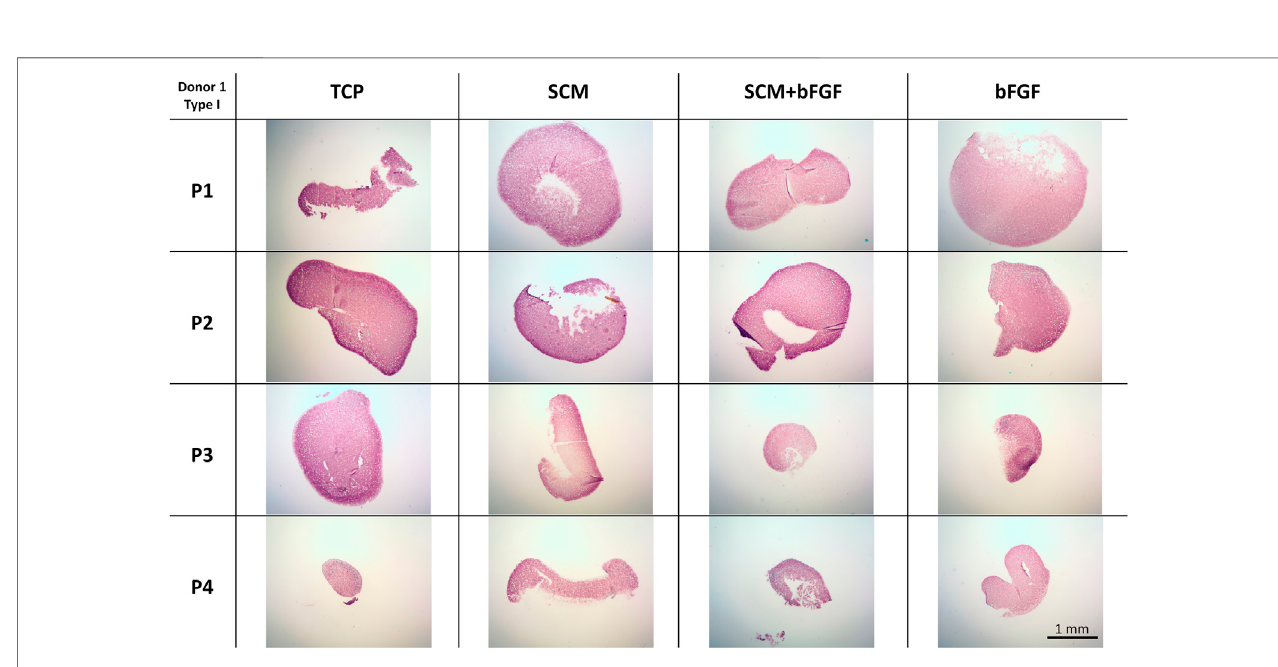
FIGURE 9 | Cartilage aggregate images showing type I collagen staining. Sections of cartilage aggregates from a single donor over the four passages in each condition are shown here stained for type I collagen. All at the same scale, scale bar 1 mm. See Supplementary Figures S8 – S10 for other donors.